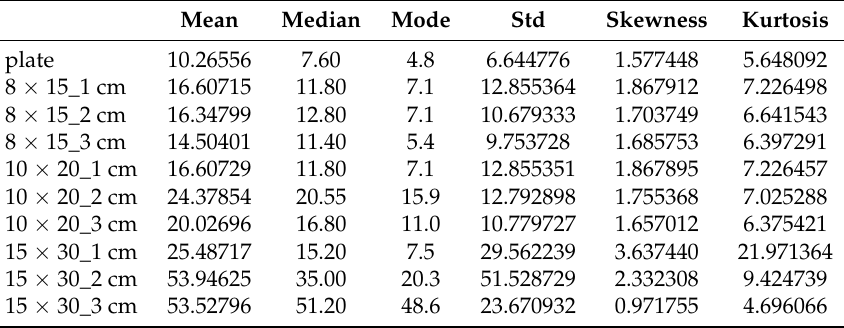
Table 1. Statistics for the timing of brine shrimp agents entering the green zone by model. All values are given in units of seconds, and both skewness and kurtosis are calculated as Pearson standardized